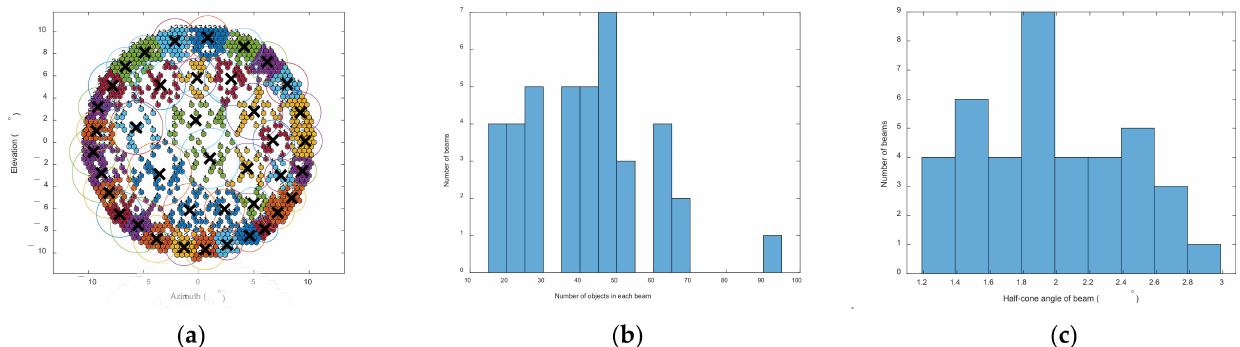
Figure 7. Optimization results of the beam allocation based on the modified K-means clustering when parameter α equals 1 and β equals 0: ( a ) Plot of the allocated 40 beams. The crossing indicates the geometrical center of each beam. The neighboring hexagonal cells in same beam are marked with same color; ( b ) Statistics of the beam occupation; ( c ) Statistics of the beam